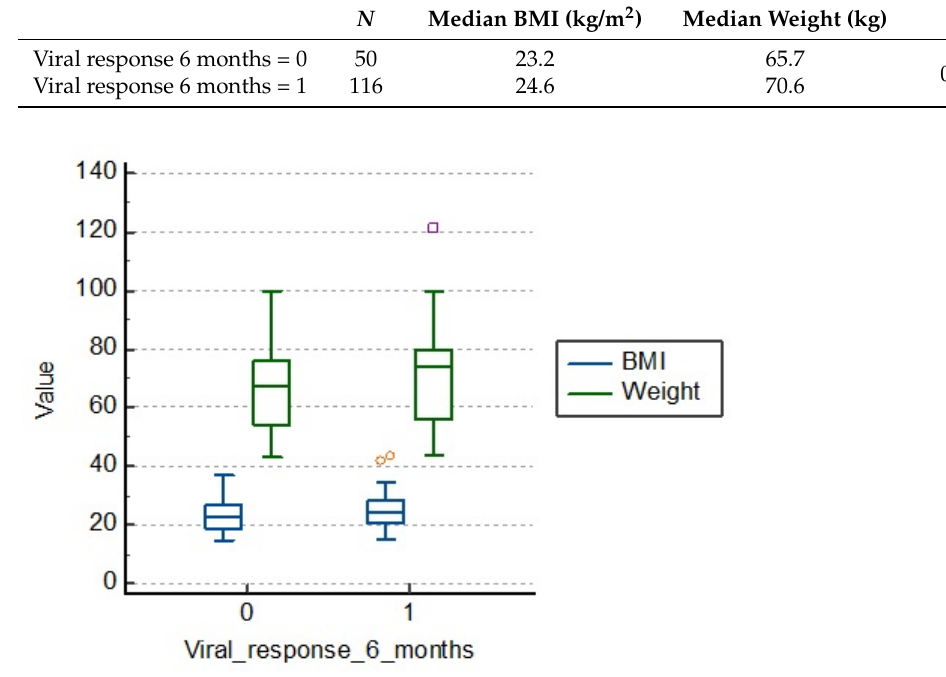
Figure 3. Distribution of BMI (body mass index) and weight at 6 months.